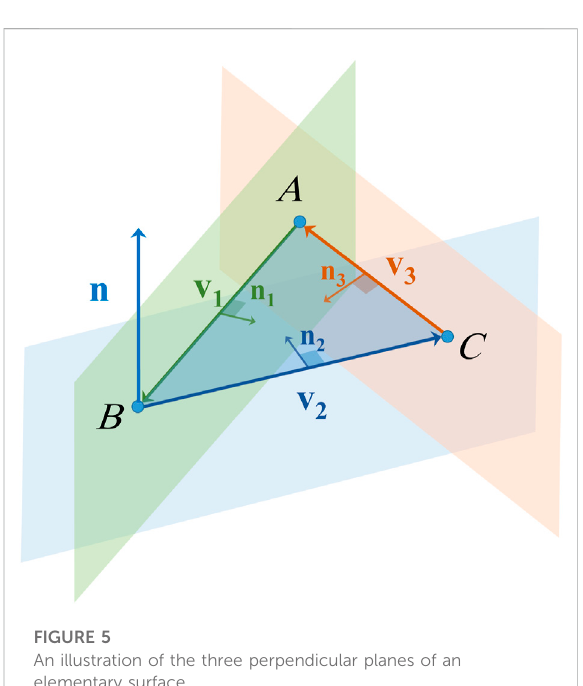
Figure 4. However, one should be careful, as this solution may increase complexity dramatically in some cases, and should be avoided if the number of the resulting points is very large. Other better solutions are presented later in Sections 3.5 and 3.6.